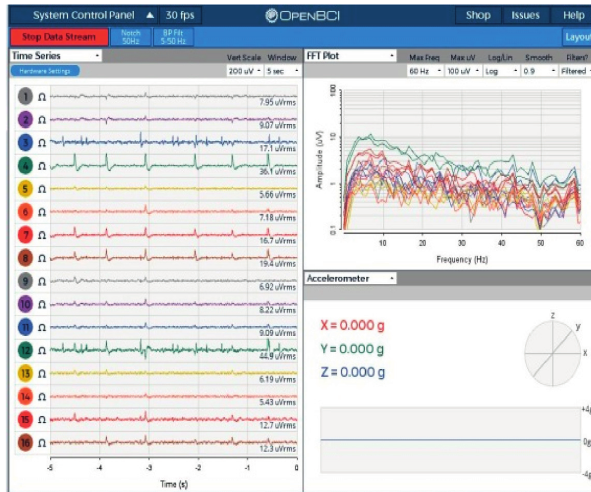
Figure 14: The EEG of shear action idea in the static